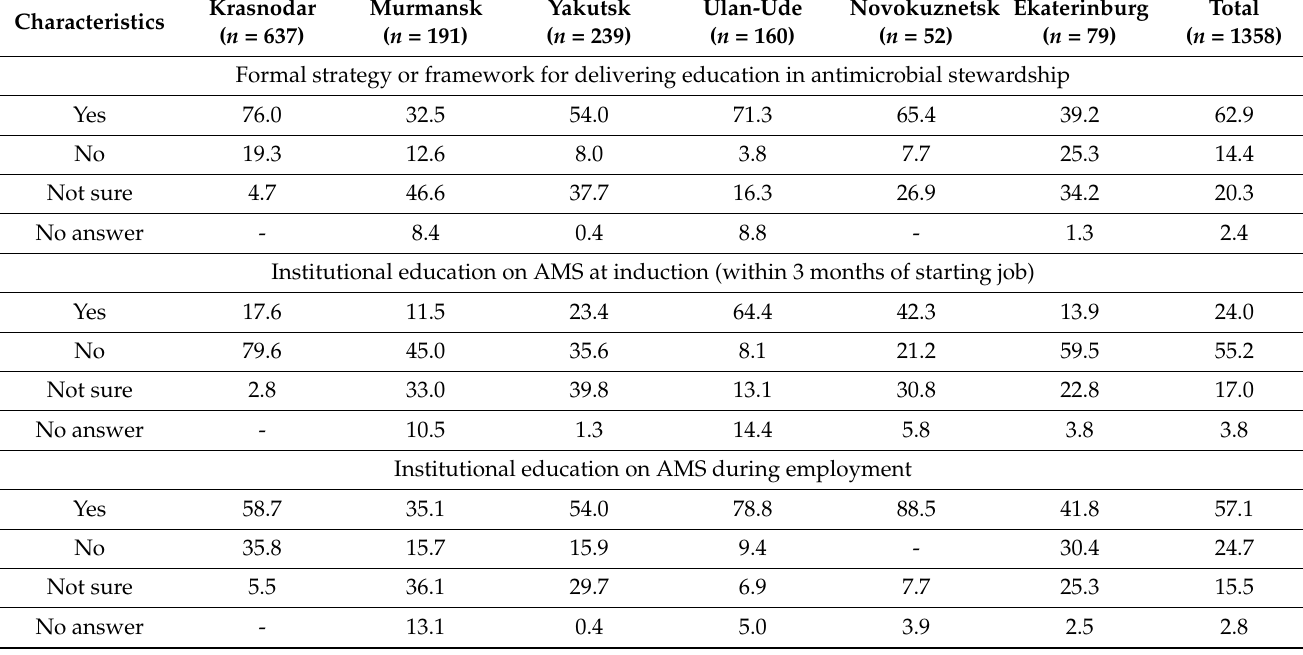
Table 6. Specification of teaching in antimicrobial stewardship, %.